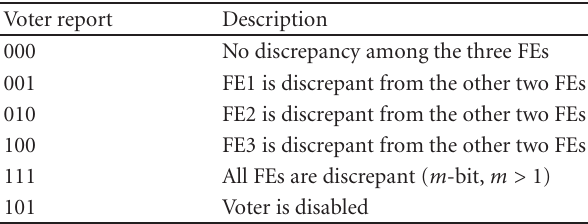
Table 2: Possible values for the voter